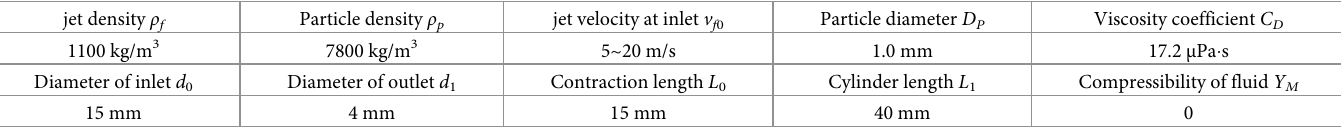
Table 1. The parameters of particle and